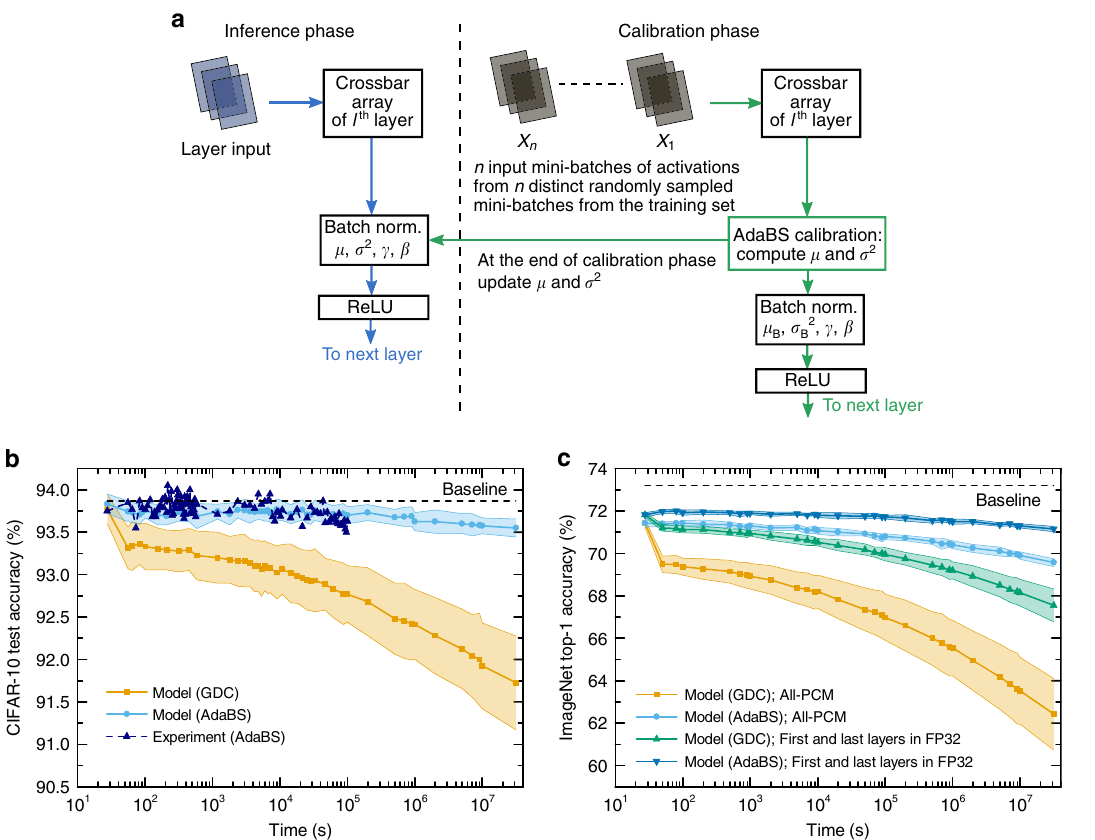
Fig. 5 Adaptive batch normalization statistics update with PCM synapses. a The AdaBS calibration procedure consists in updating the running mean μ and variance σ 2 parameters of the batch normalization performed in the digital unit of the in-memory computing hardware. The calibration is performed periodically when the device is idle, and after calibration the values of μ and σ 2 of every layer are updated for subsequent inference. Note that during the calibration phase, batch normalization is performed using the mini-batch mean μ B and variance σ 2 instead of μ and σ 2 (see Methods and Supplementary B Note 3). b Test accuracy of ResNet-32 on CIFAR-10 with GDC and AdaBS using the PCM model, along with experimental test accuracy obtained by applying AdaBS on ResNet-32 with the measured weights from the PCM chip. The fi lled areas from the PCM model correspond to one standard deviation over 25 inference runs. c Top-1 accuracy of ResNet-34 on ImageNet with GDC and AdaBS computed using the PCM model. Implementations using PCM synapses for all layers as well as fi rst and last layers in digital FP32, and PCM synapses for all other layers, are shown. In the latter, no noise is applied on the fi rst and last layers during training. The fi lled areas correspond to one standard deviation over 10 inference runs. In b and c the baseline refers to the FP32 software